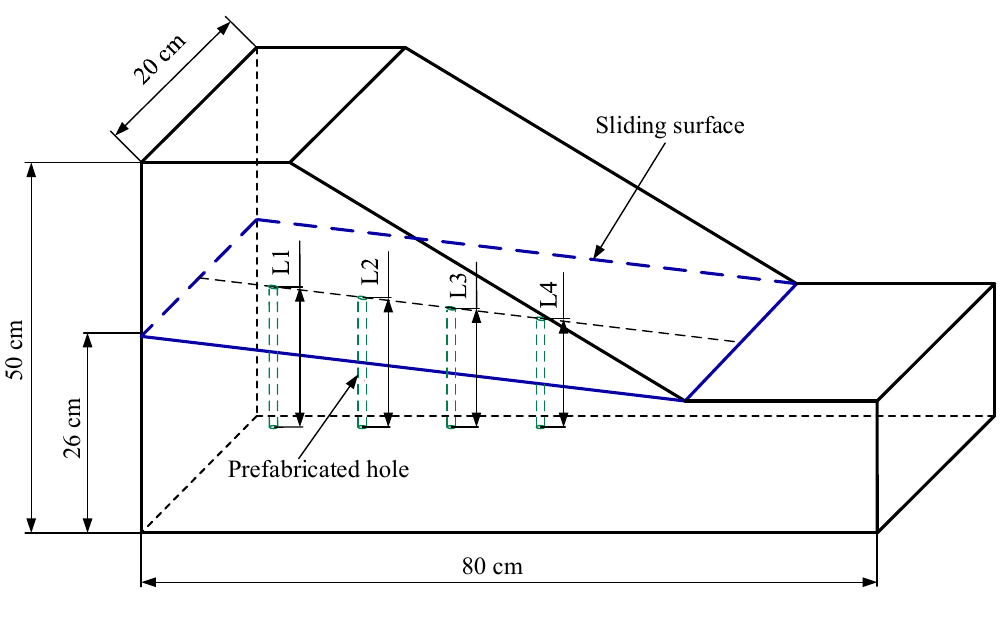
Figure 5. Schematic of slope model.